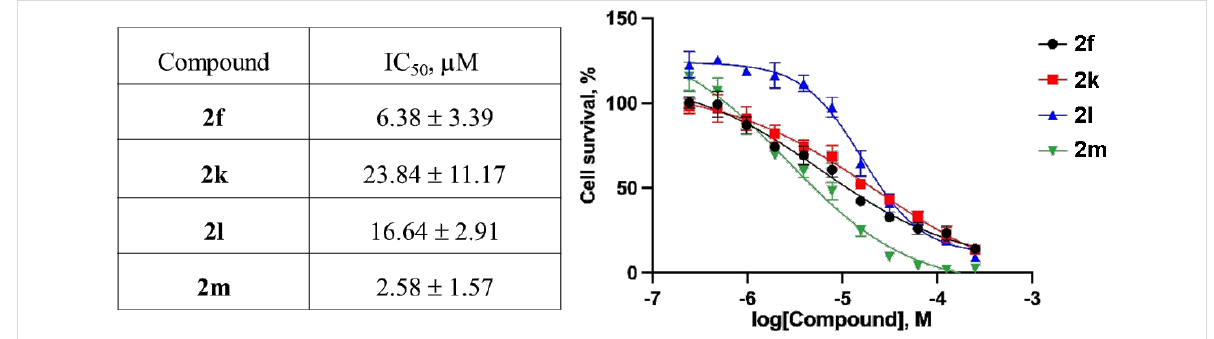
Figure 2: Cytotoxicity of N -alkyl-substituted dibenzoazulenodipyrroles 2 against the A549 human lung adenocarcinoma cell line (the IC 50 values are mean values from three different assays).